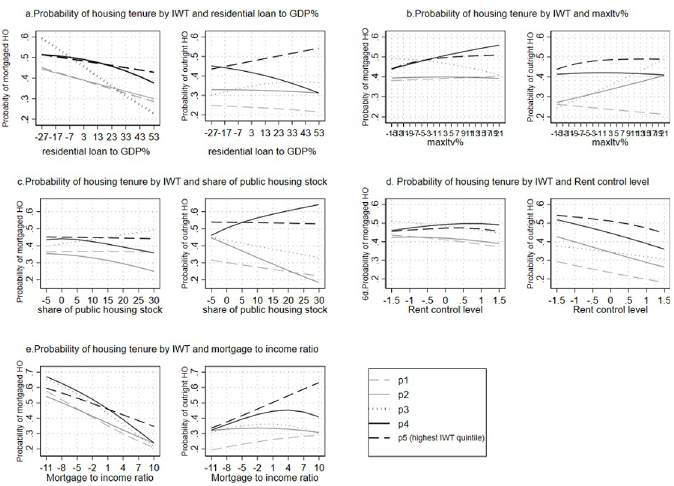
Fig 6. a–e. Predictive margins of pooled multinomial logistic regression predicting the difference in probability of housing tenure by IWT quintiles and macro variables (reference group: Non-homeownership) . Note: Macro variables are centered around the